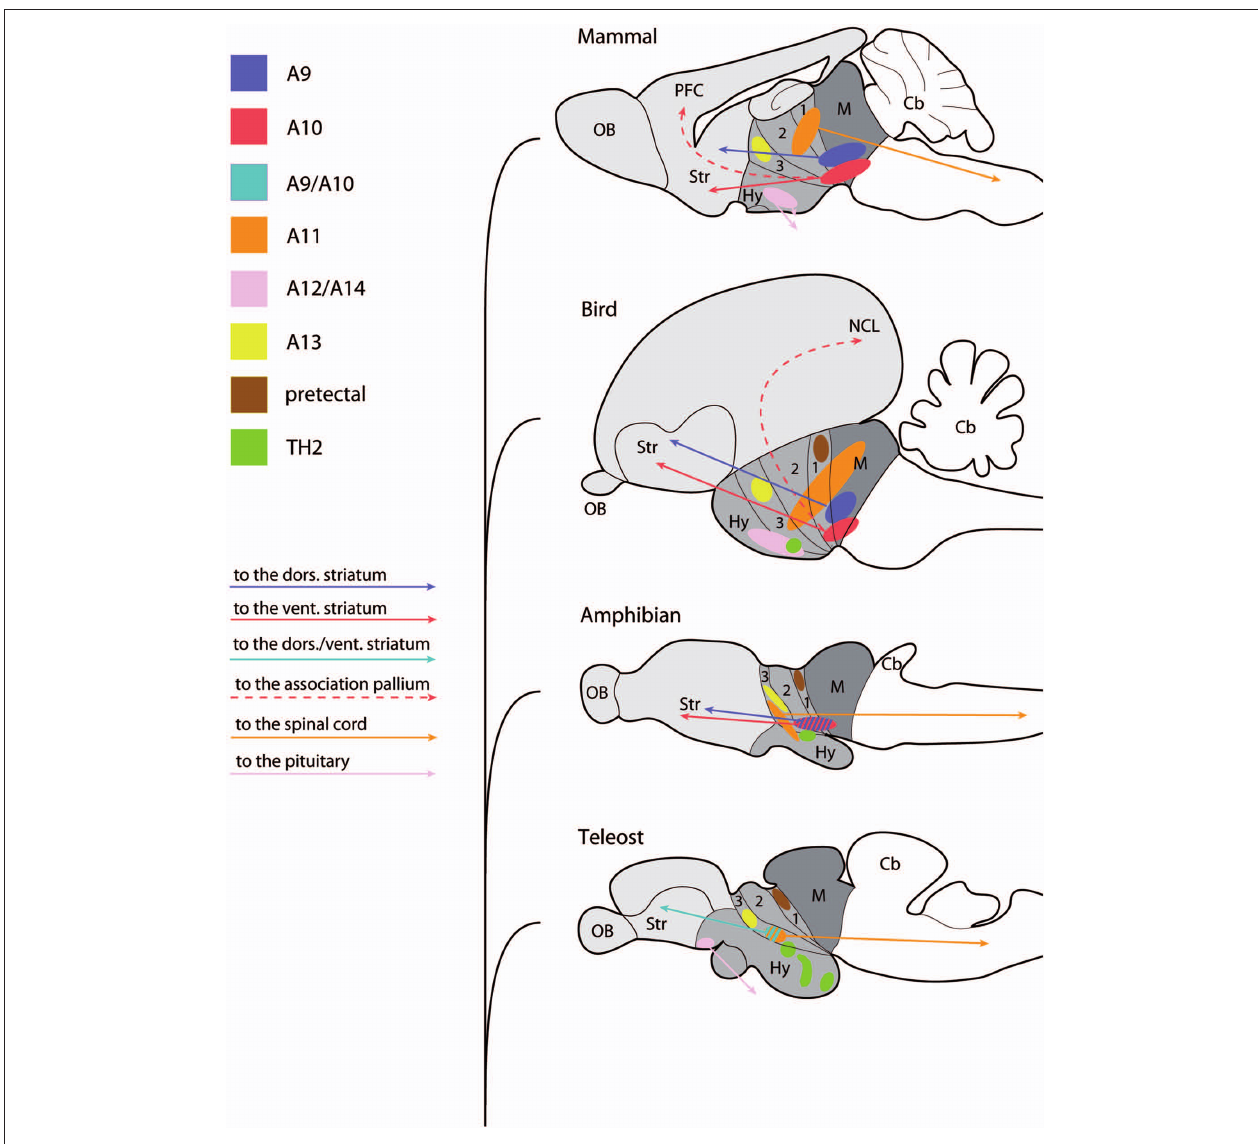
populations. TH2 (green) and pretectal (brown) DA cell groups are commonly found in vertebrates except mammals. Midbrain is shaded with dark gray, diencephalon in gray, and telencephalon in light gray in the brain of each species. The approximate positions of prosomeres p1–p3 are indicated as segmentation within